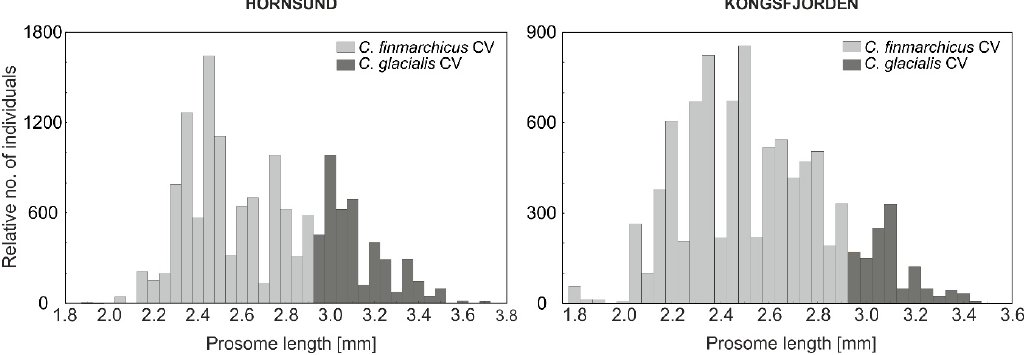
Figure 8. Prosome length frequency distribution of copepodite stage CV of Calanus finmarchicus and C . glacialis classified according to morphological identification after Kwasniewski et al. [55] in Hornsund (n = 1798) and Kongsfjorden (n = 799).